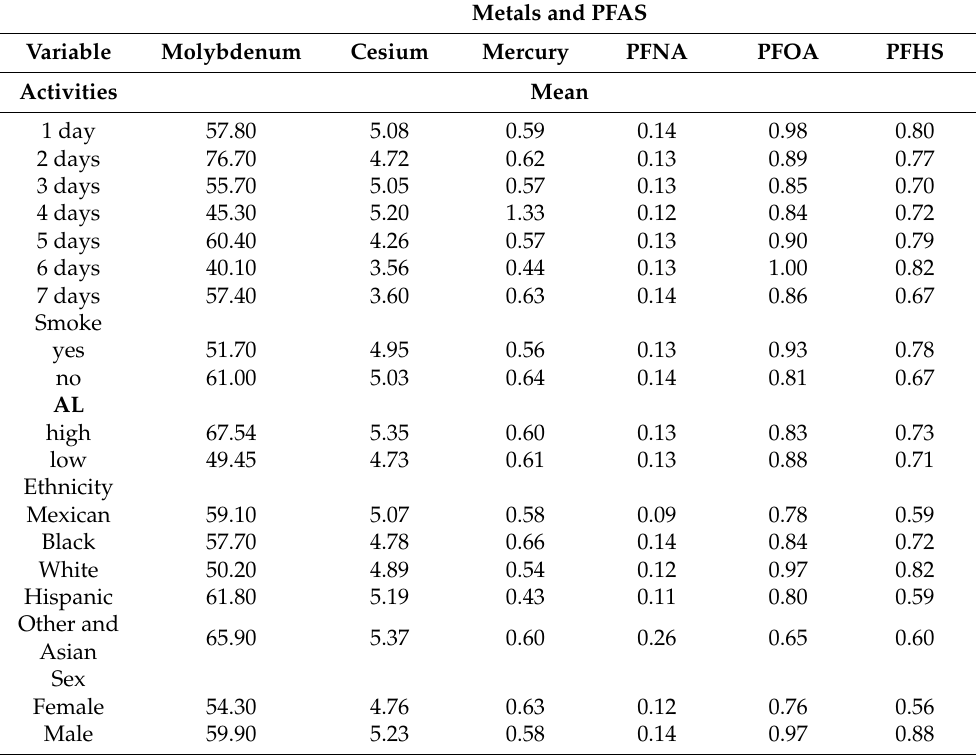
Figure 2. Univariate exposure-response functions and 95% confidence intervals for each metal and PFAS exposure, with others fixed at the median. Table 2. Metals (molybdenum, cesium, and mercury) and PFAS (PFNA, PFOA, and PFHS) means by critical study